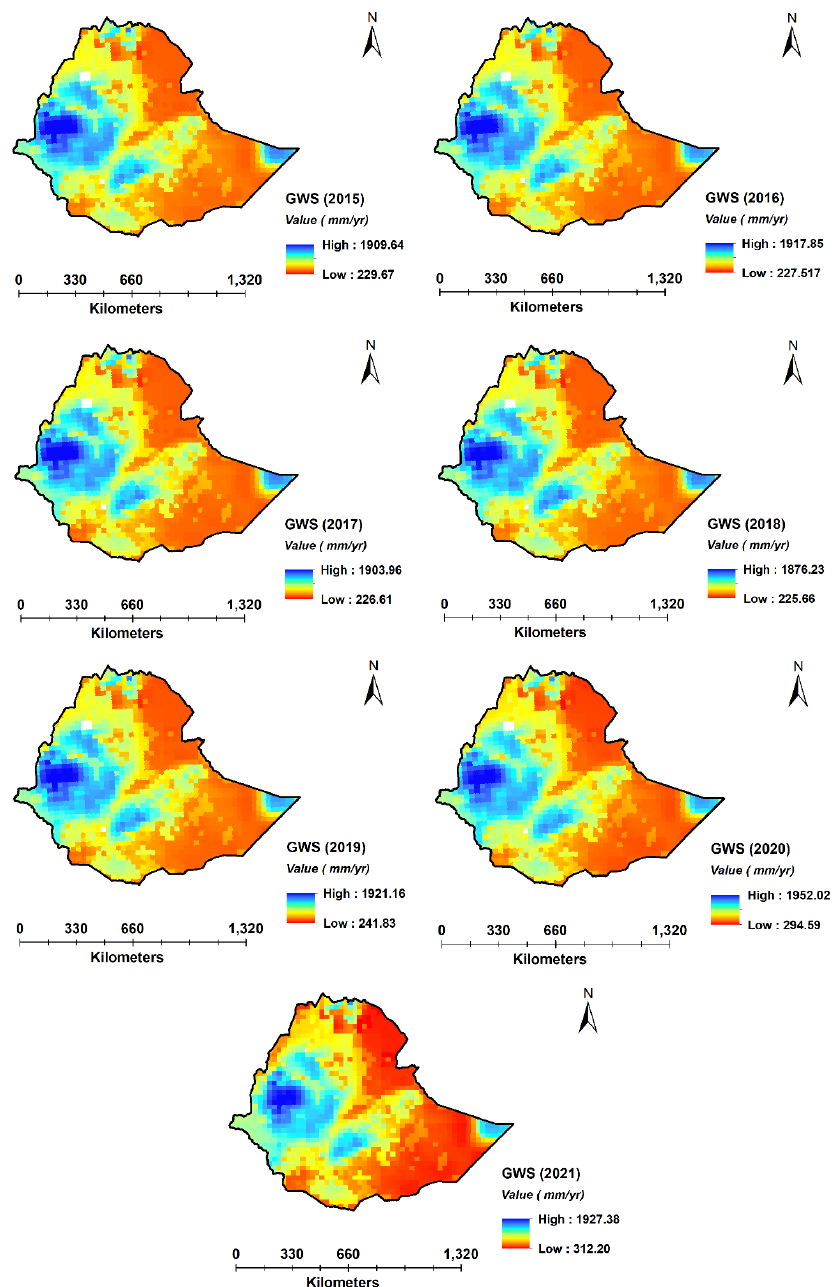
Figure 11. Annual groundwater storage (GWS) maps from GLDAS 2 CLM (2015–2020) in Ethiopia.